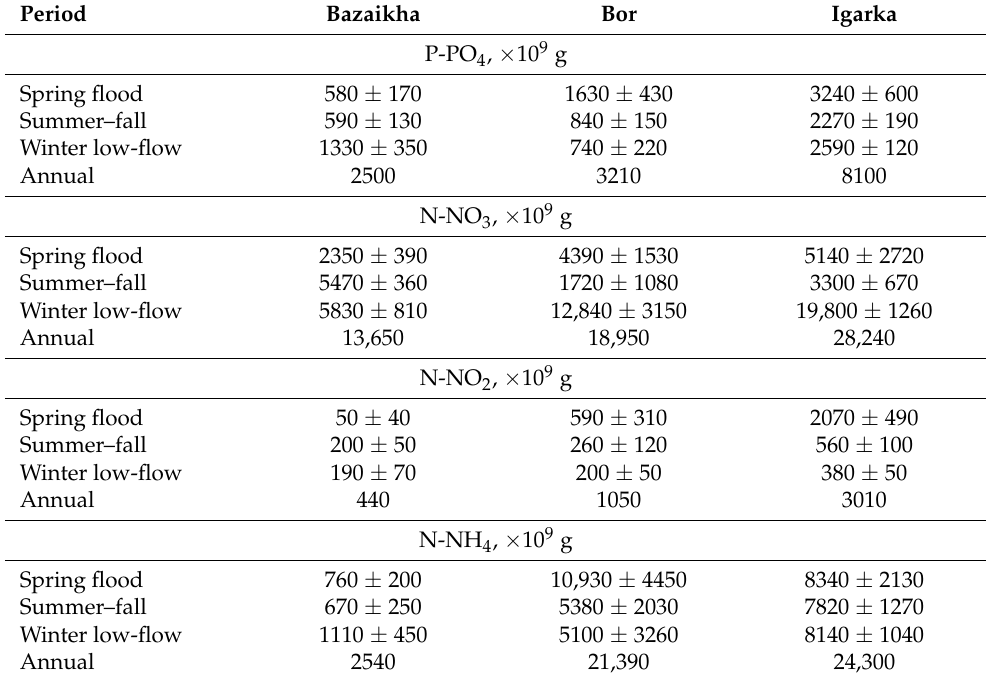
Table 4. Seasonal and annual fluxes of nutrients at the gauging stations of the Roshydromet network: Bazaikha (Krasnoyarsk), Bor (Podkamennaya Tunguska) and Igarka. Period Bazaikha Bor Igarka P-PO 4 , × 10 9 g Spring flood 1630 ±